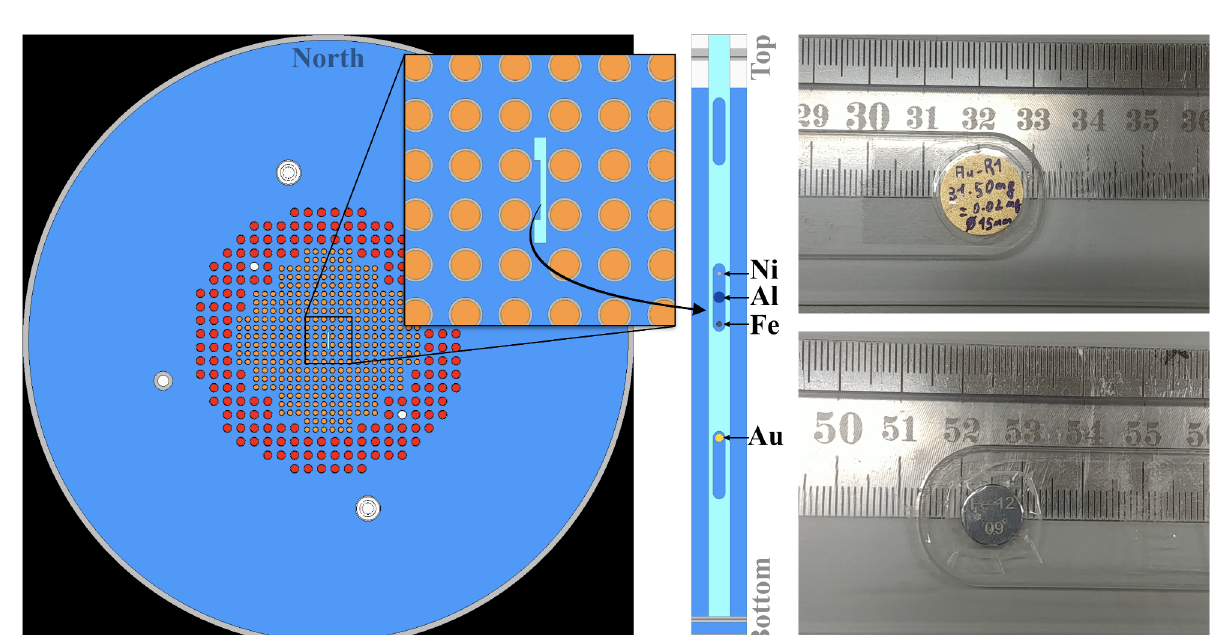
Figure 1: Plastic plate positioning in the CROCUS core using Serpent2 geometry visualization (left) and picture of the dosimeters on the plastic plate (right).